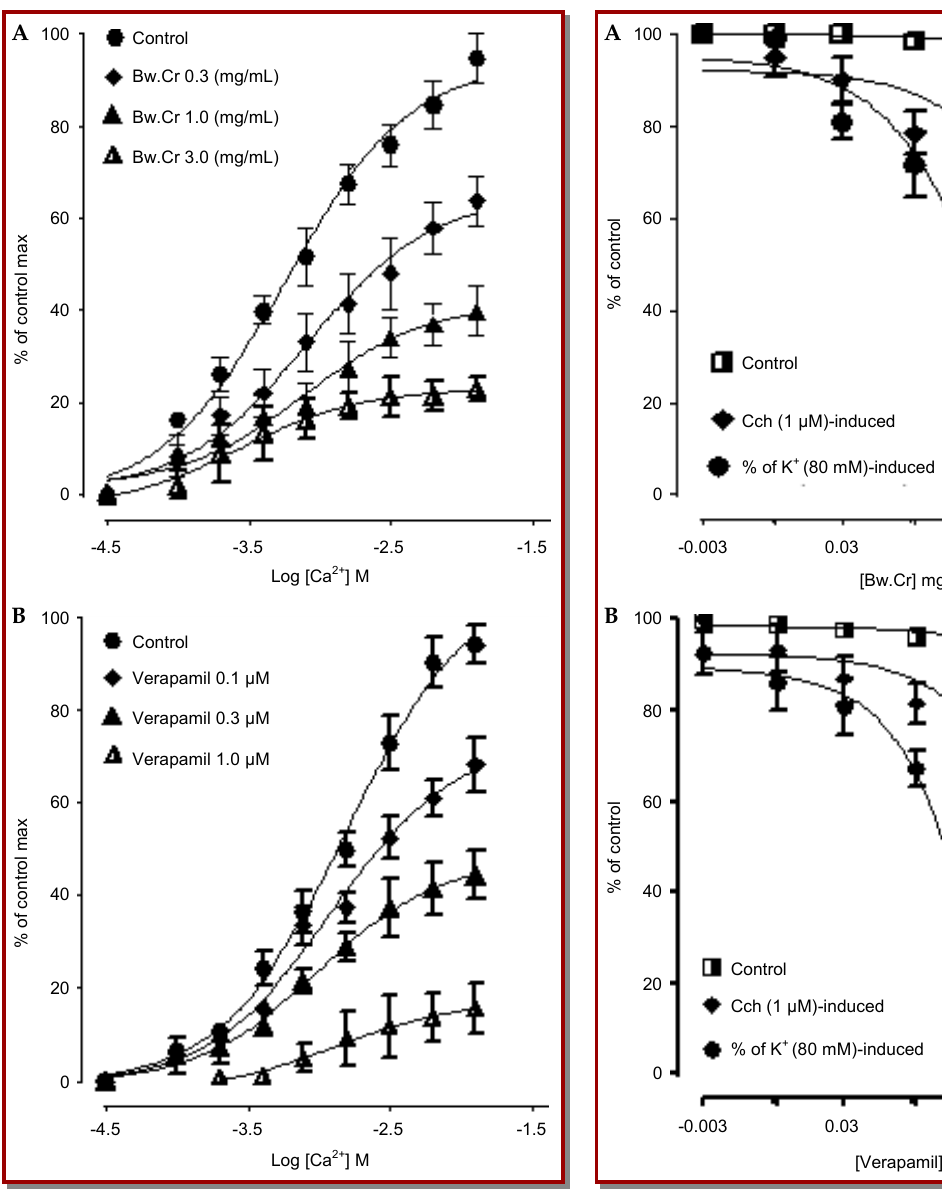
Figure 5 : Concentration-response curves showing inhibitory effect of (A) crude extract of B. wallichiana and (B) verapamil against K + (80 mM)- and carbachol (1 µM)-induced contractions in isolated rabbit trachea preparations (values are expressed as mean ± SEM, n = mM)- and phenylephrine (1 µM)-induced contractions (0.02 – 0.42, 95% CI, n=3) and 1.25 mg/mL (0.62 – 2.11, 95% CI, n=3) respectively (Figure 6B). Crude extract shifted the Ca +2 - concentration response curves at the dose range of 0.3 – 1.0 mg/mL (n=3) to the right, like that caused by verapamil at 0.1 – 0.3 μ M (n=3), thus